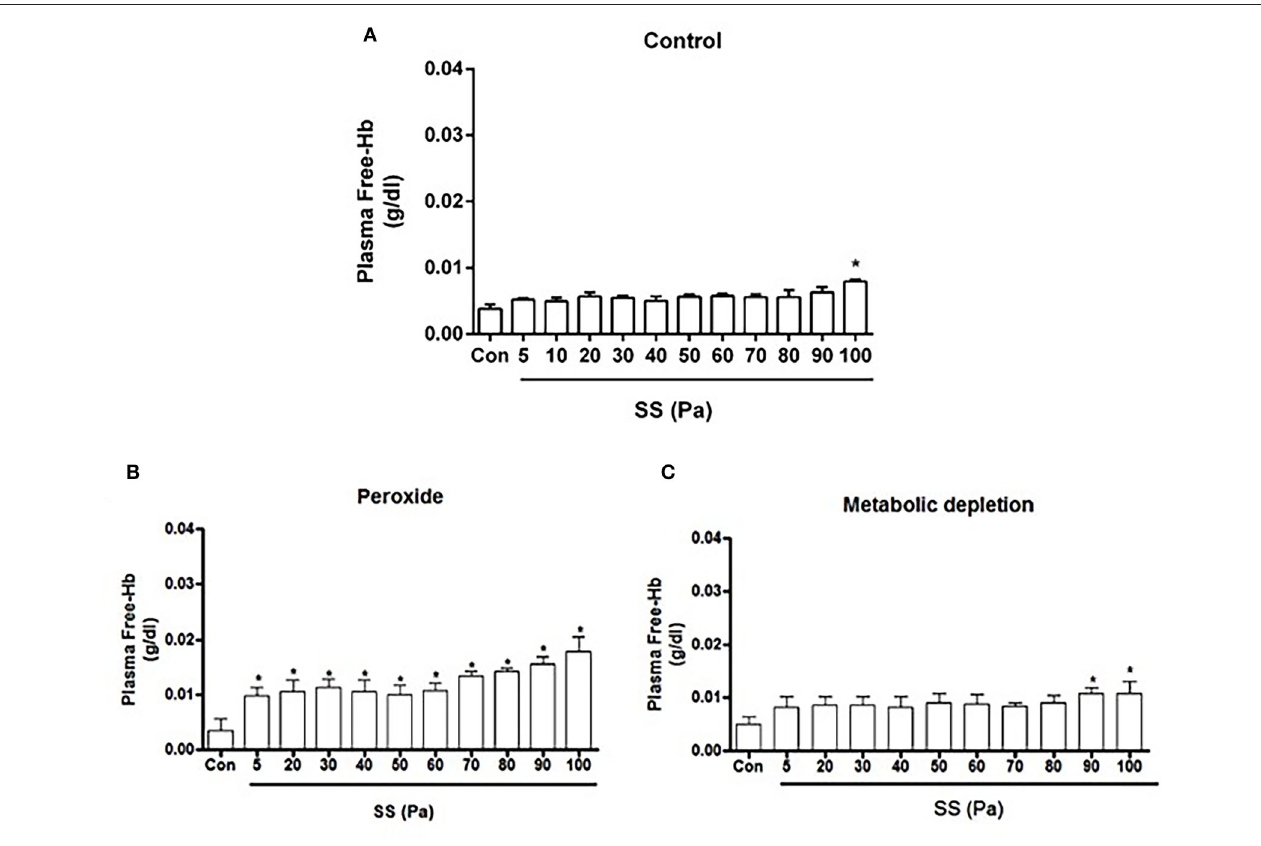
FIGURE 1 | Free Hb concentration of healthy (A) , oxidative stress (B) and metabolic depletion (C) groups. Con: RBC sample before preconditioning SSs. Data are represented as mean ± SEM of n = 5. * p < 0.05 refers to the difference from Con (one-way